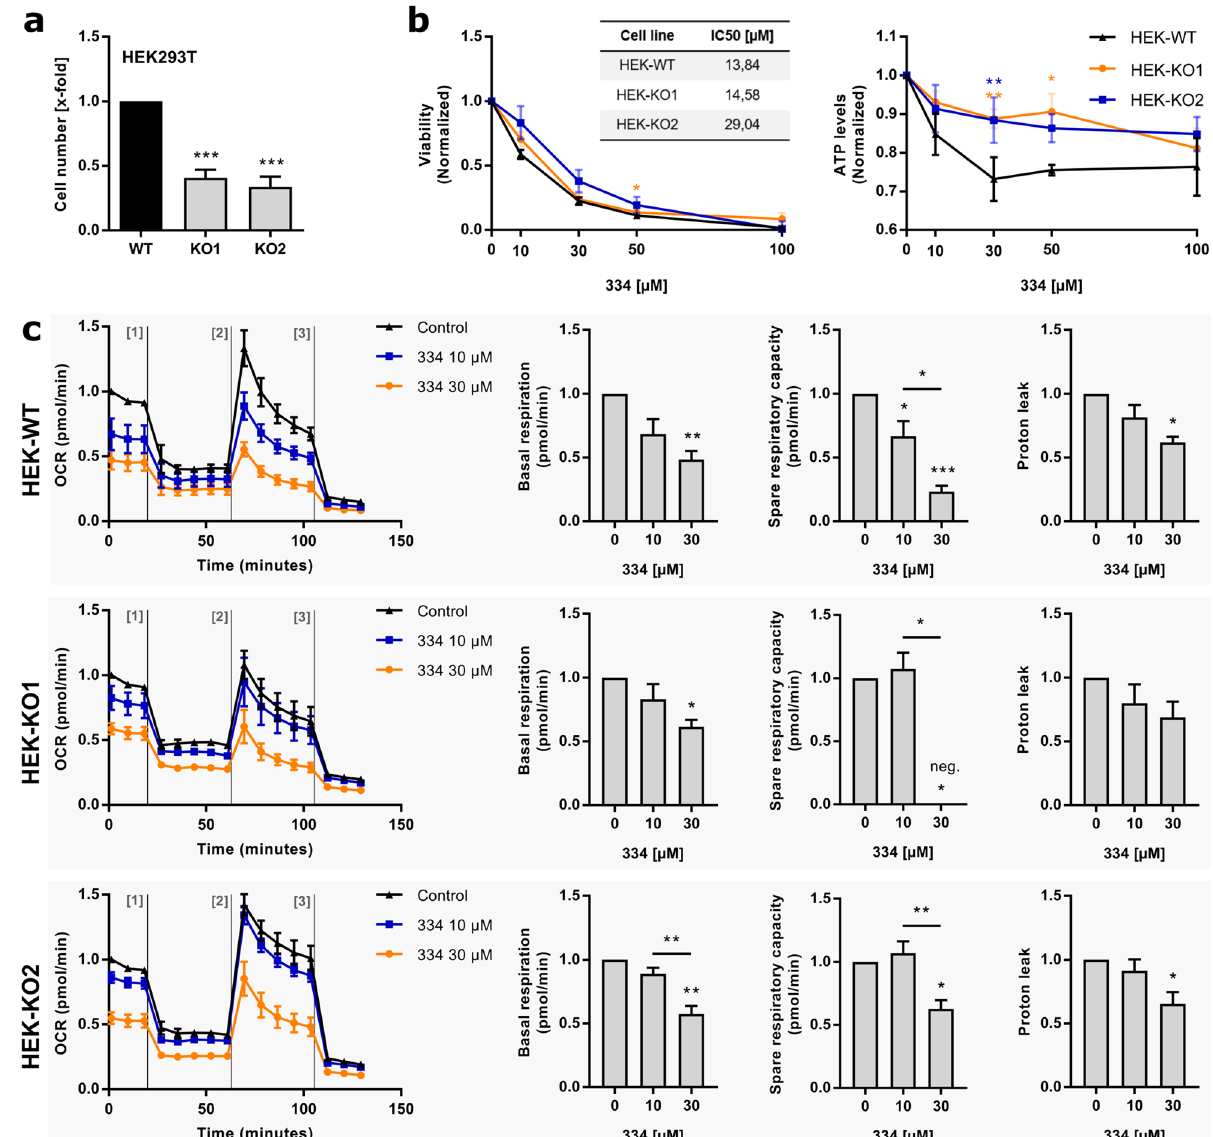
Figure 6. ClpP-KO impairs metabolic impact of 344 treatment. ( a ) Proliferation of HEK293T cells is impaired by knockout (KO) of the ClpXP complex. Cell number of HEK293T cells (HEK-WT) and two distinct ClpP-KO clones 30 (HEK-KO1, HEK-KO2) was assessed by crystal violet staining 72 h after cell seeding and normalized to HEK-WT (*** P < 0.001, One-way ANOVA, Tukey’s Multiple Comparison Test, n = 3). ( b ) An intact ClpXP complex is required for 334-mediated reduction of ATP production. Viability with corresponding IC 50 values (left panel) and ATP levels (right panel) of HEK-WT, HEK-KO1 and HEK-KO2 cells are shown. Cells were treated with 334 (10 µM, 30 µM, 50 µM, 100 µM) for 3 h (ATP production) or 72 h (Viability) and results were normalized to the untreated control of the respective cell type (* P < 0.05, ** P < 0.01, paired t-test comparing HEK-KO1 or HEK-KO2 to HEK-WT, n = 3). ( c ) Respiratory capacity of ClpP-deficient (−/−) HEK (HEK-KO) cells is not altered by low-dose (10 µM) 334 treatment. The OCR over time was assessed for HEK-WT and HEK-KO1/HEK-KO2 cells untreated or treated with 334 (10 µM and 30 µM) for 24 h via mitochondrial stress test on an Agilent Seahorse XF Analyzer. OCR measurements were performed untreated and after injection of Oligomycin (2.5 µM), FCCP (0.5 µM) and Rotenone/Antimycin A (0.5 µM). Basal respiration, spare respiratory capacity and proton leak were assessed as described in (Supplementary Fig. S6a online). The FCCP titration for HEK-WT cells is shown in Supplementary Fig. S6b online (last panel) (* P < 0.05, ** P < 0.01, *** P < 0.001, One- way ANOVA, Tukey’s Multiple Comparison Test, n =